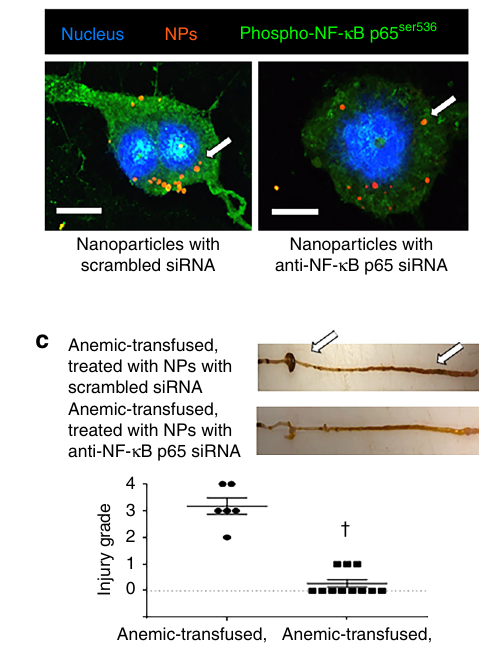
anemic mice (1 nmol intravenously and 2 nmol intraperitoneal; pre-determined optimum) 24 h prior to RBC transfusion. Mice treated with anti-p65 NPs were protected (Fig. 8b, c). The pre- sence of these NPs inside the Ly6C + intestinal macrophages was evident from detection of the Cy3 fl uorescence tag of our NPs in